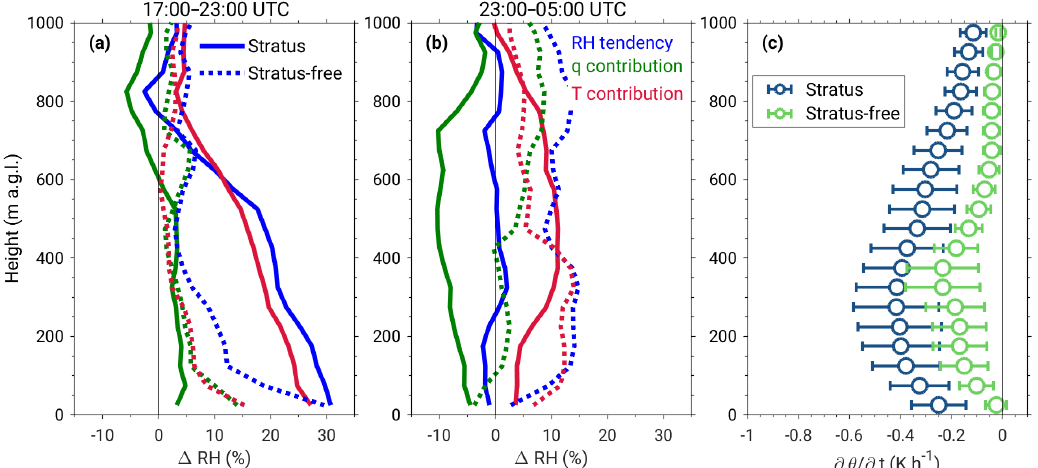
Figure 10. The observed RH tendency profiles obtained from radiosonde measurements for the period 17:00–23:00UTC (a) and 23:00– 05:00UTC (b) are shown in blue. The contributions from specific humidity changes and temperature changes are shown in green and red, respectively. Solid lines represent the stratus case (IOP 7), and dotted lines show the stratus-free case (IOP 10). (c) Mean profiles of the contributions by horizontal advection to the observed cooling for the period 17:00–23:00UTC for stratus case (blue) and for the period 23:00–05:00UTC in stratus-free case (green). Error bars indicate the standard deviation, which is estimated from the calculations for three coastal stations (Abidjan, Accra and Cotonou) and four different maximum inland propagation distances of the maritime inflow front (50, 75, 100 and